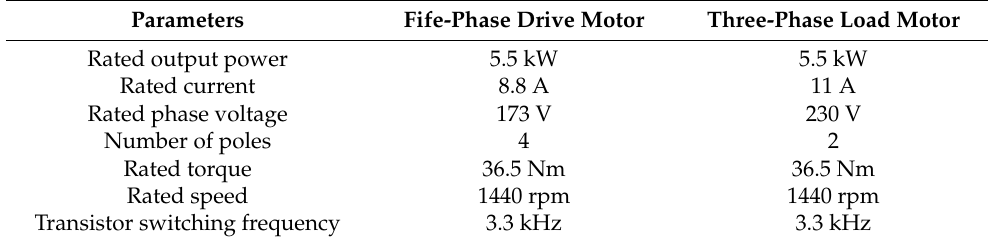
Table 1. Parameters of the five-phase drive system with load motor [15].